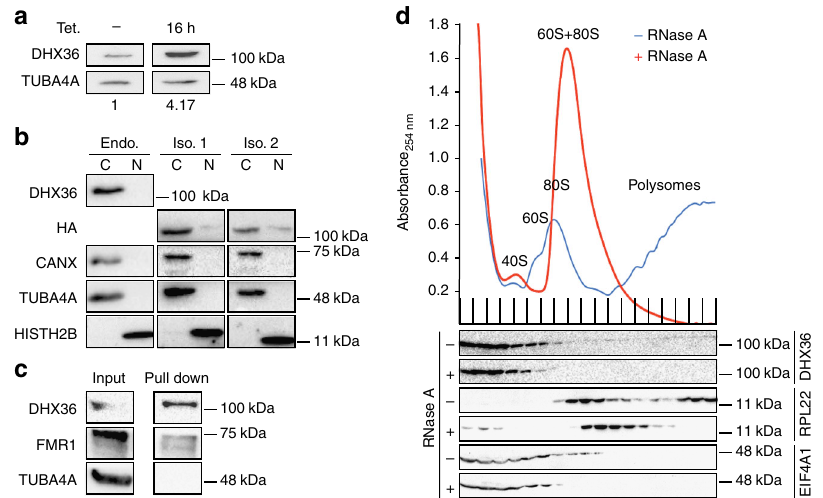
Fig. 1 DHX36 is mainly cytoplasmic and does not directly interact with ribosomes. a Quanti fi cation of transgenic FLAG/HA(FH)-DHX36 expression upon 16 h induction with tetracycline (Tet.). TUBA4A-normalized DHX36 quantities are indicated below. b Endogenous (Endo.), as well as transgenic FH-tagged DHX36 isoform 1 (Iso. 1) and 2 (Iso. 2) show mainly cytoplasmic localization in biochemical fractionation experiments from HEK293 cells. Cytoplasmic (C) and nuclear (N) fractions were probed with anti-HISTH2B (nuclear marker), anti-TUBA4A (cytoplasmic marker), and anti-CANX (endoplasmic reticulum marker) antibodies. Endogenous DHX36 and transgenic FH-DHX36 isoforms 1 and 2 were detected with anti-DHX36 antibody and anti-HA antibody, respectively. c DHX36 can be co-puri fi ed with polyadenylated RNA. The RBP FMR1 served as a positive, TUBA4A as a negative control, respectively. d UV absorbances at 254 nm of RNase A-treated (red) and untreated (blue) HEK293 cell extracts separated by sucrose gradient centrifugation are shown. Peaks of UV absorbance corresponding to 40S, 60S, 80S ribosomes, and polysomes are indicated. Western blots probed for DHX36, RPL22, and EIF4A1 are shown below. Source data are provided as a Source Data fi le